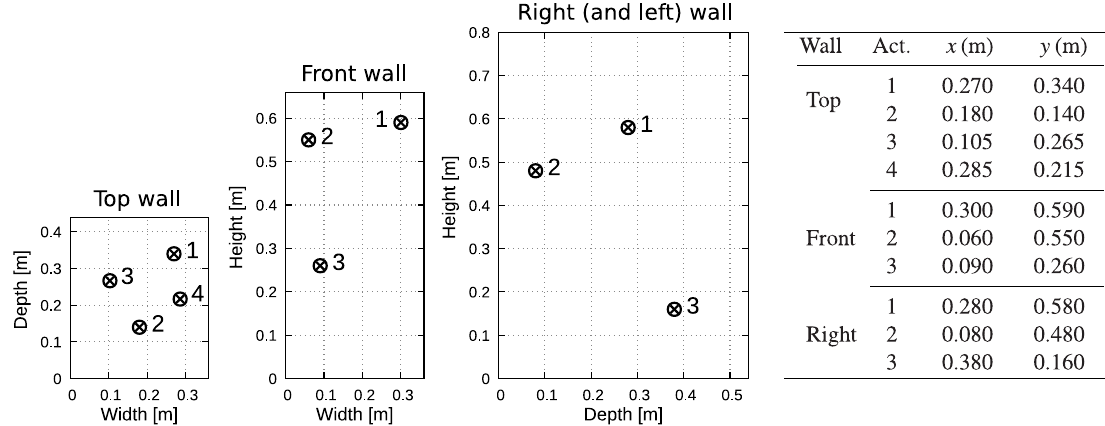
Figure 3. Arrangement of actuators on the washing machine casing walls. The pair of walls was symmetrical ( left and right ); hence, only one of them is presented (the front is at depth equal to 0). Version January 2, 2020 submitted to Appl. Sci. 6 of 12